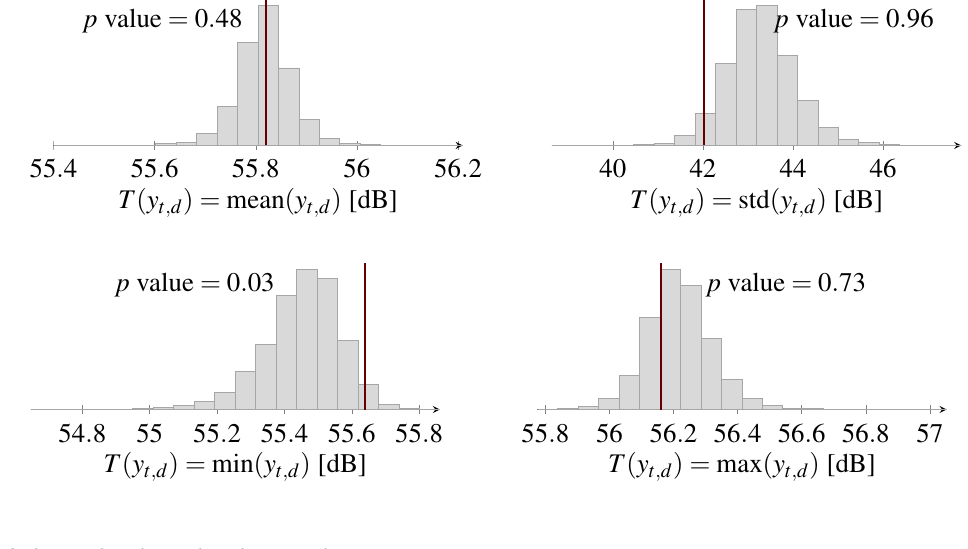
Figure 14. Posterior predictive checking for predicted (modeled) transponder data y four different test statistics. Especially the most important aspect of the predicted data, its mean, is well modeled.